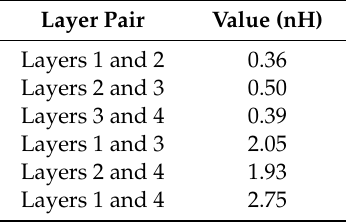
Figure 6. Finite element analysis of coil structure applied to two non-adjacent inner layers: ( a ) layers 1 and 3; ( b ) layers 2 and 4; and ( c ) layers 1 and 4. Table 2. Mutual inductance according to the coil structure.